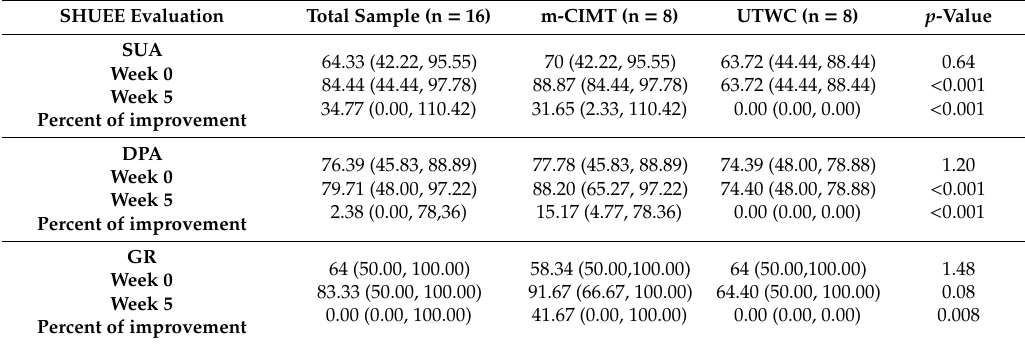
Table 2. Results and percent of improvement per group and total sample in the variables measured with the Shiners Hospital Upper Extremity Evaluation (SHUEE) evaluation.